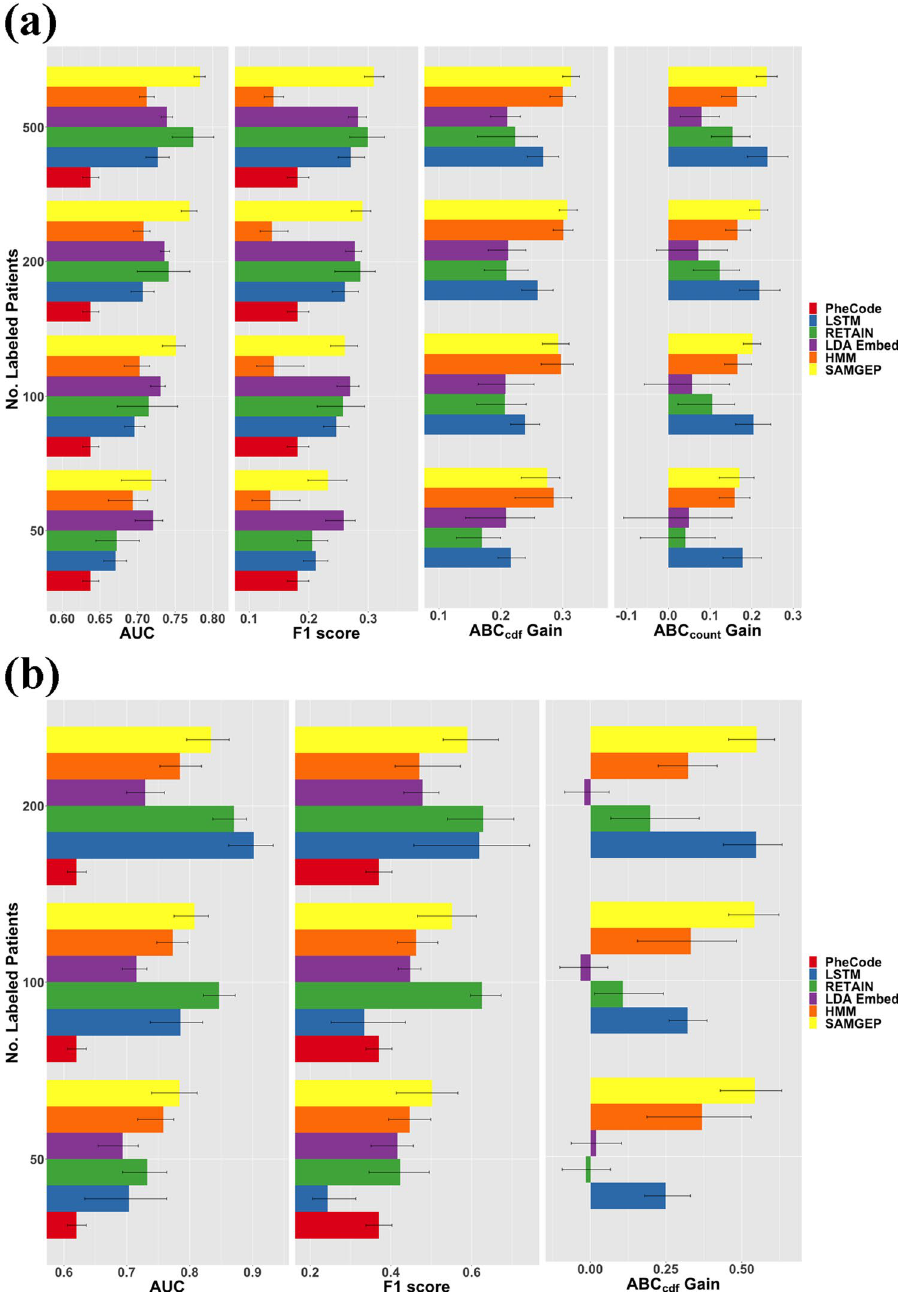
Figure 4. Predictive accuracies of SAMGEP and various comparator methods using real-world EHR data to predict ( a ) MS relapse with n ∈ { 50, 100, 200, 500 } labeled patients, and ( b ) HF onset with n ∈ { 50, 100, 200 } labels. 95% confidence intervals were empirically estimated by bootstrapping with 100 replicates. See the “Evaluation metrics” subsection of the “Methods” for details about the evaluation metrics. More extensive results are displayed in Supplementary Fig.